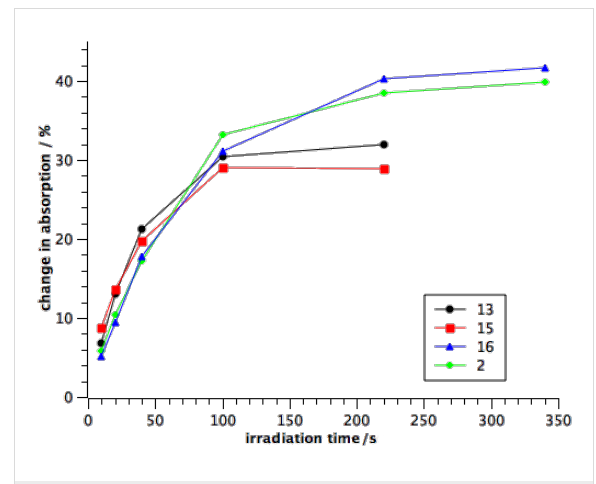
an increase of the n– π * band. In this respect all compounds display similar characteristics and show a comparable degree of isomerization (Figure 3).